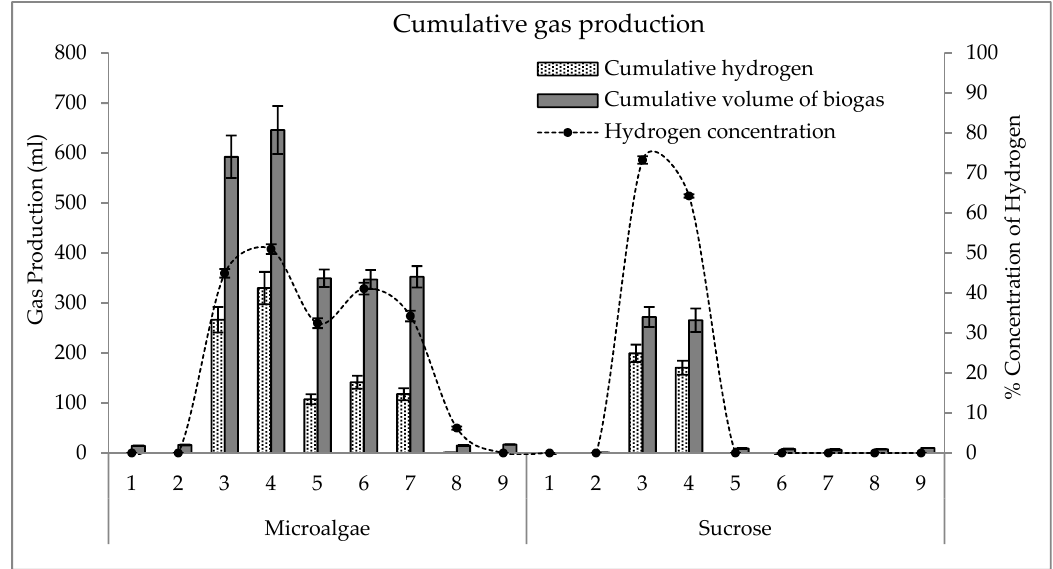
Figure 2. Hydrogen production of batch fermentation from microalgae ( Chlorella sp.) with sucrose as a control set under different conditions for initial concentration, pH, and temperature (Batch Sets 1–9) based on Taguchi design.